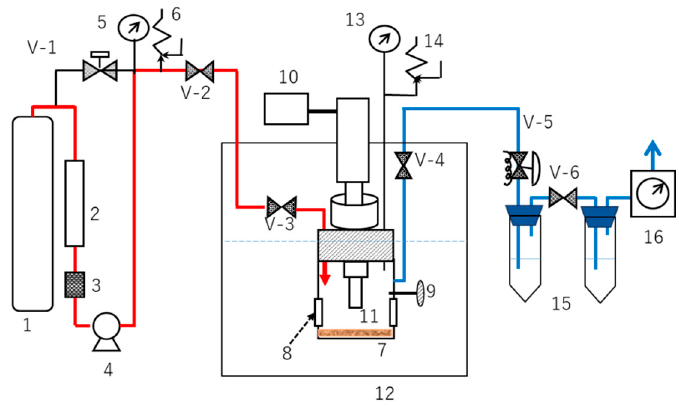
Figure 1. Schematic diagram of CO 2 -expanded liquid (CXL) extraction apparatus. (1) CO 2 cylinder; (2) cooling unit; (3) filter; (4) pump; (5) pressure gauge; (6) safety valve; (7) high-pressure cell; (8) quartz glass window; (9) thermometer; (10) ultrasonic processor; (11) ultrasonic horn; (12) water bath; (13) pressure gauge; (14) safety valve; (15) cold traps; (16) gas flow meter; (V-1, V-5) back pressure regulators; and (V-2, V-6) stop valves.